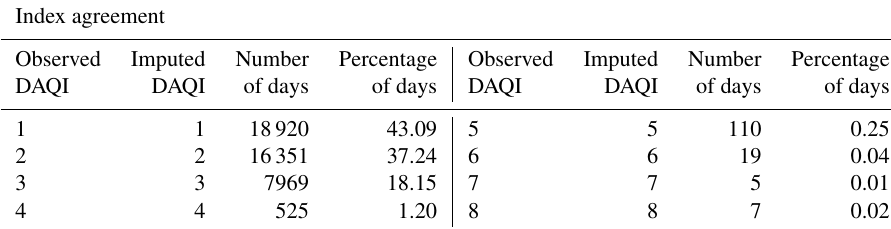
Table 4. Number of days for which imputed DAQI agrees or disagrees with observed